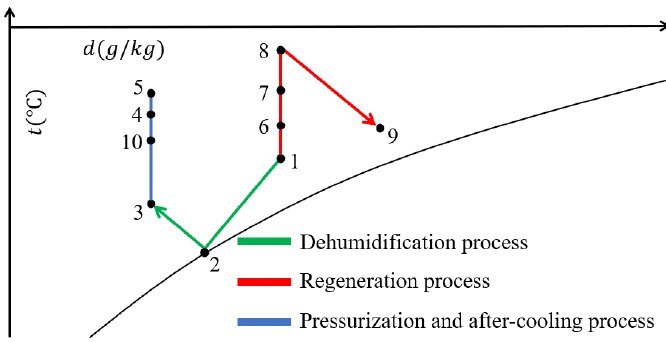
Figure 2. Schematic of the hybrid dehumidification system (HDS).